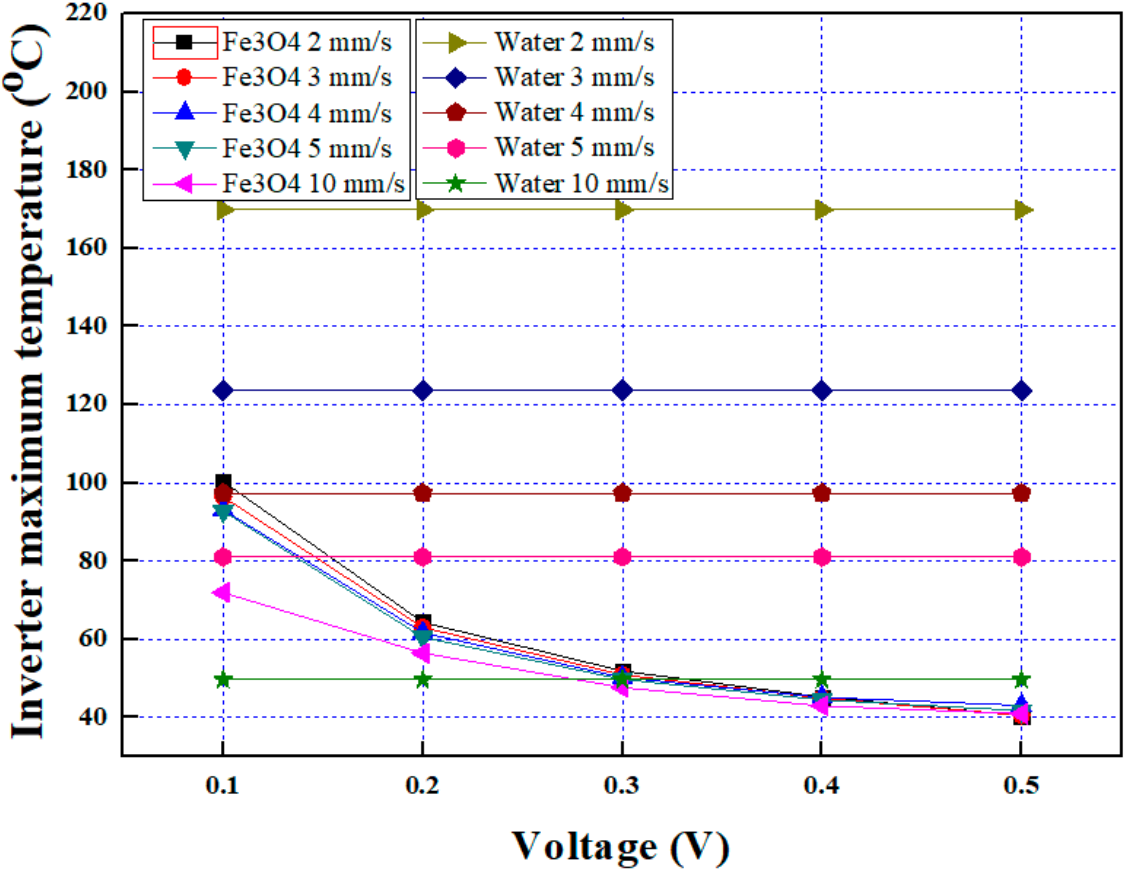
Figure 8. Comparison of inverter maximum temperature for water and ferrofluid cooling under various conditions of inlet velocity and voltage.